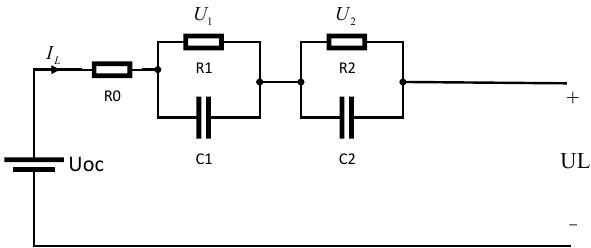
Figure 4. Voltage curve during a single charge-discharge process.